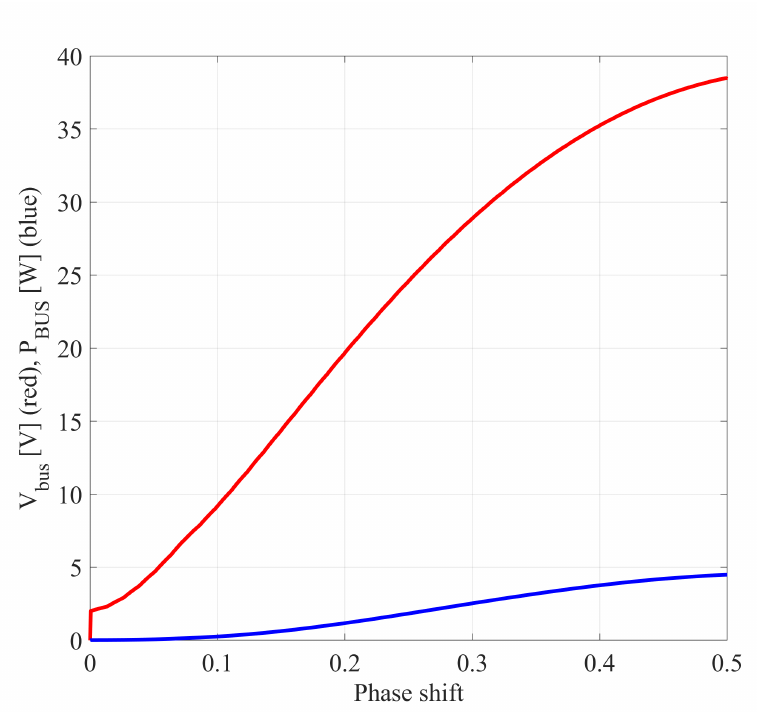
Figure 21. Simulation results of the voltage V bus and the power P bus versus one phase shift, with the other at zero constant value, V PV = 10 V, V bat = 0 V and R LOAD = 330 Ω